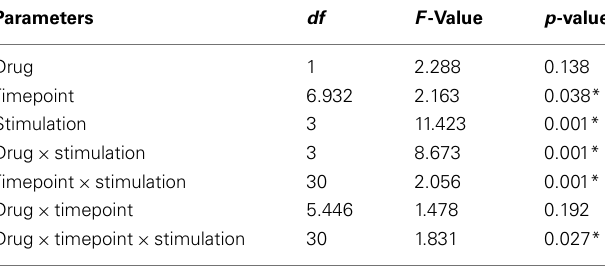
Table 2 | Results of